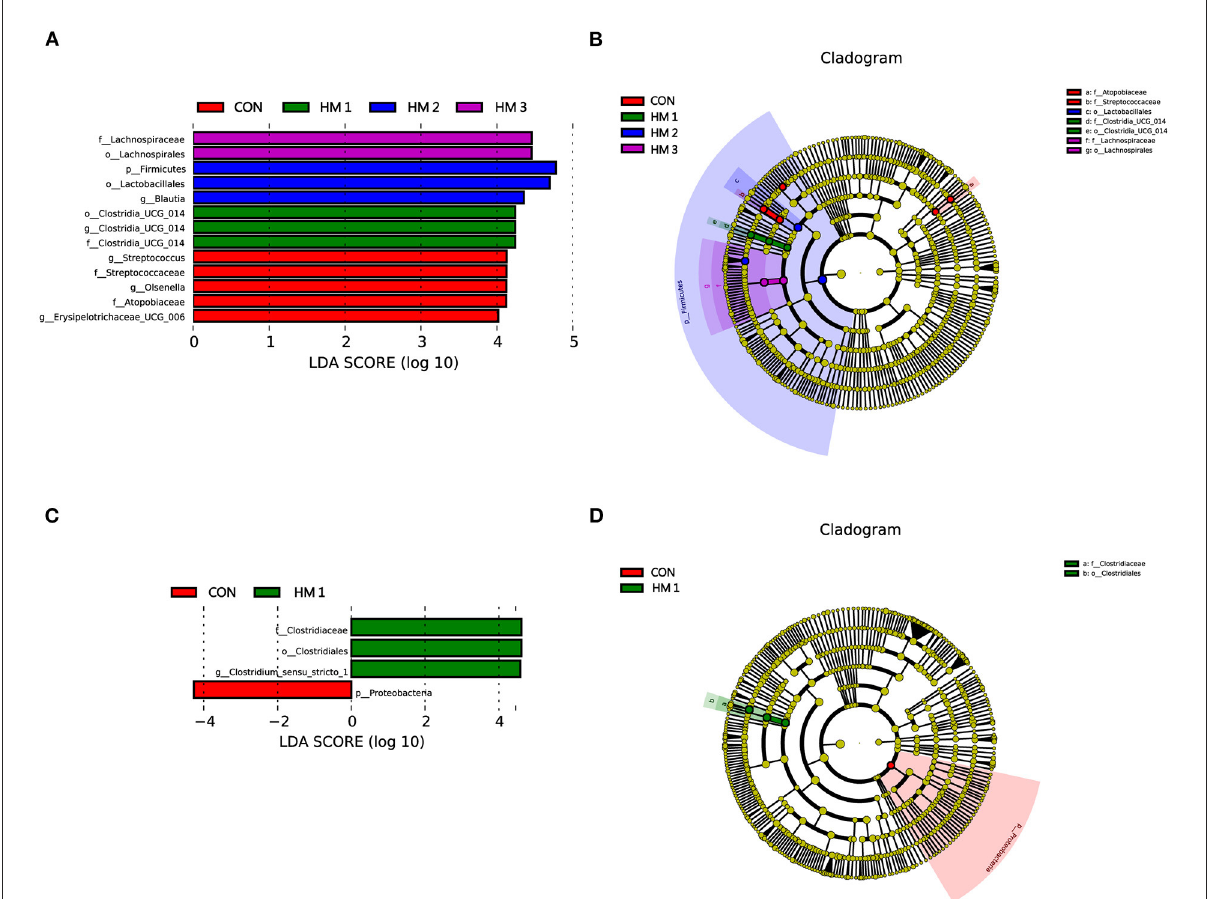
FIGURE5 Linear discriminant analysis coupled with effect size (LEFse). The LEfSe analysis identified the differentially abundant (LDA score > 4) bacterial taxa between the HM group and the CON group on day 14 (A) or on day 28 (C) . A linear discriminant analysis (LDA) score higher than 4 indicates that the relative abundance of the corresponding group is higher than that of the other groups. The abscissa of the bar chart represents the LDA value, and the ordinate is the different species of the selected treatments. Cladogram showing the most discriminative bacterial clades identified by LEfSe between the HM group and CON group on day 14 (B) or on day 28 (D) . LEfSe taxonomic clade: Different colors indicate that some taxa are enriched in different groups. The size of a circle is based on relative abundance. CON, basic diet; HM1, basic diet with 0.5 g/kg of herbal mixture; HM2, basic diet with 1.0 g/kg of herbal mixture; HM3, basic diet with 1.5 g/kg of herbal